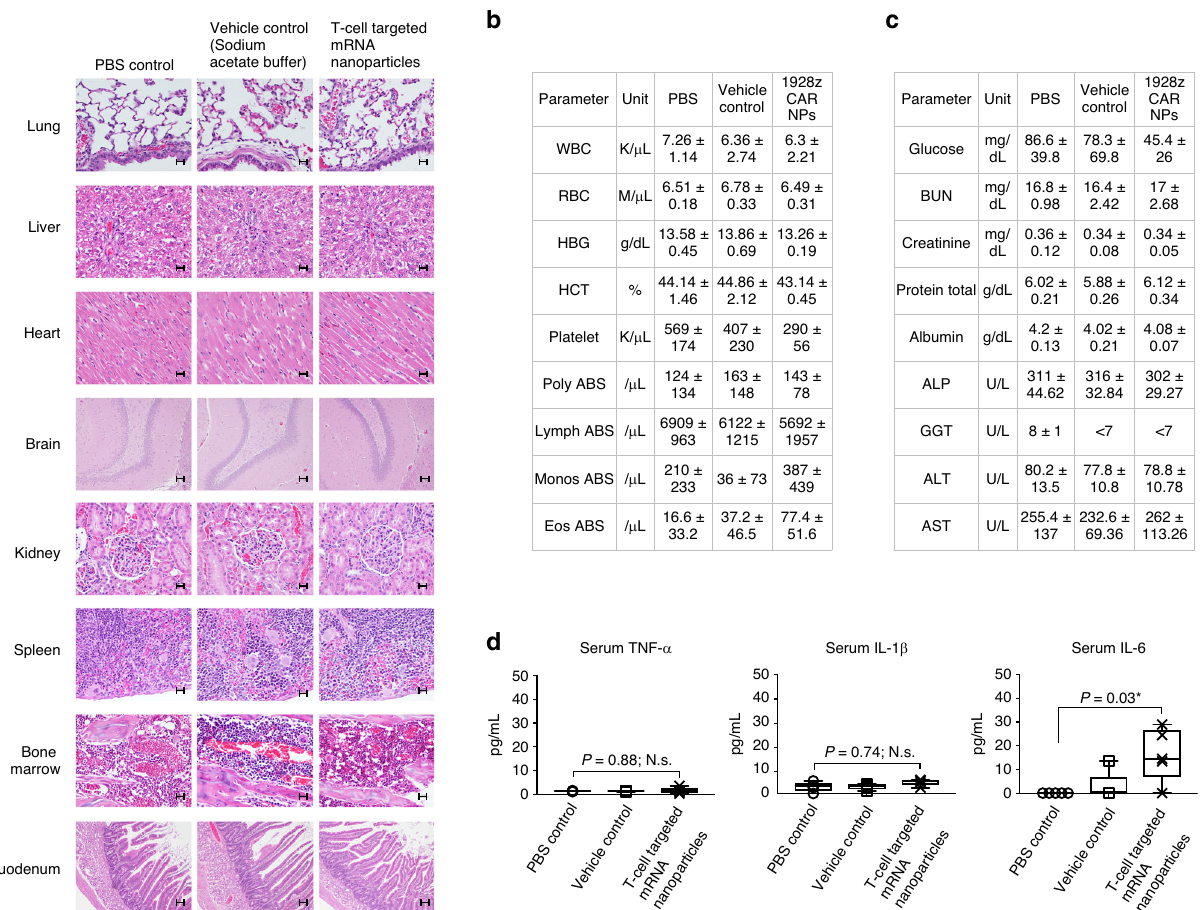
Fig. 10 Infusions of nanocarriers are not associated with acute systemic toxicities. Female Sprague Dawley rats were intravenously infused with CD8- targeted IVT mRNA encoding the 1928z CAR, and a full histopathological evaluation as well as serum chemistry analysis were performed 48 h later in a blinded fashion by a board-certi fi ed pathologist. a Representative H&E-stained sections of various organs isolated from controls or nanoparticle-treated animals. Scale bars, 400 µ m. b Blood counts and c serum chemistry. d ELISA measurements of serum TNF- α , IL-1 β , and IL-6 cytokines. On each box plot, the central mark indicates the median, and the bottom and top edges of the box indicate the interquartile range. Whiskers represent 95% con fi dence intervals. Two tailed unpaired Student ’ s t -test. N = 5 biologically independent animals/group pooled from two independent